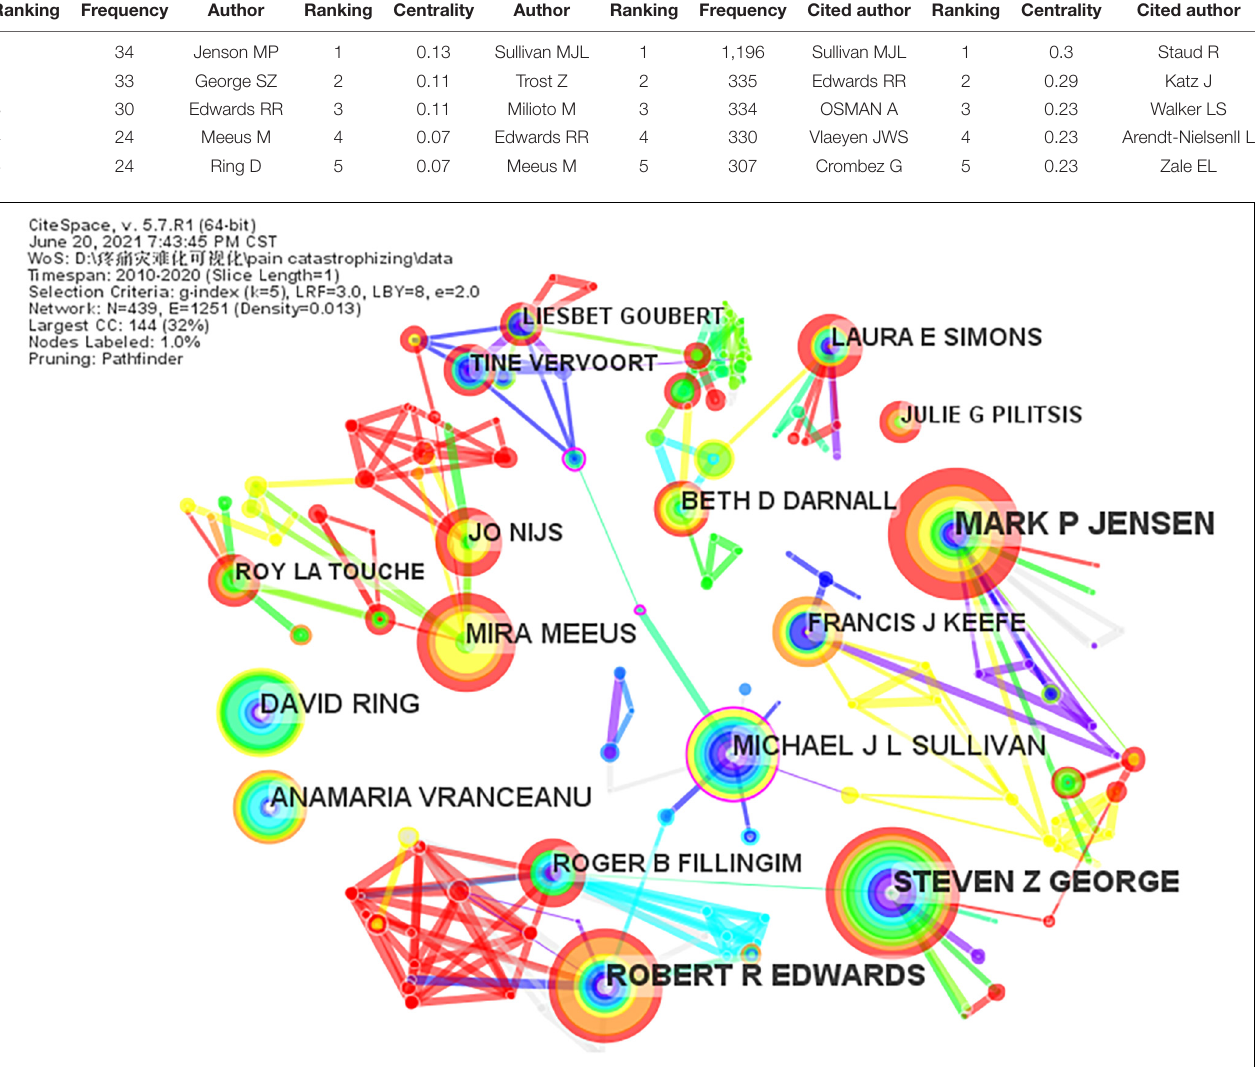
Frontiers in Psychology |